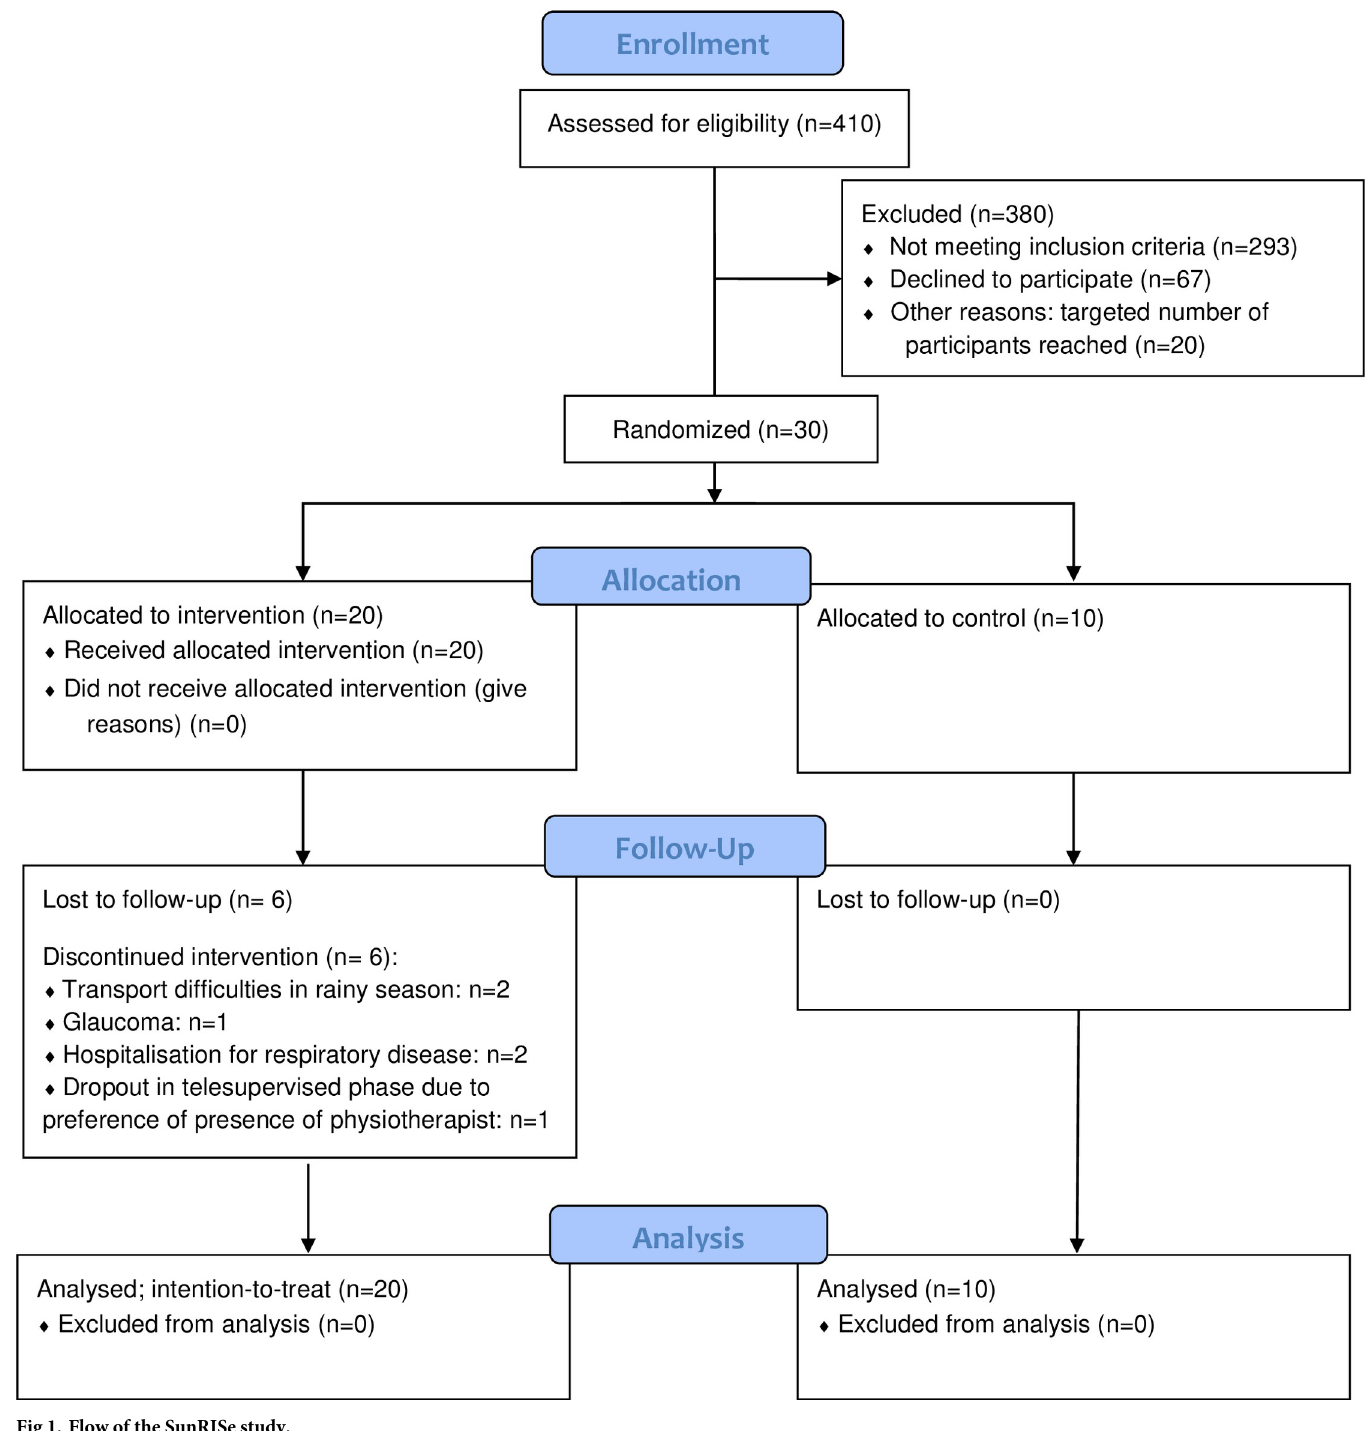
Fig 1. Flow of the SunRISe